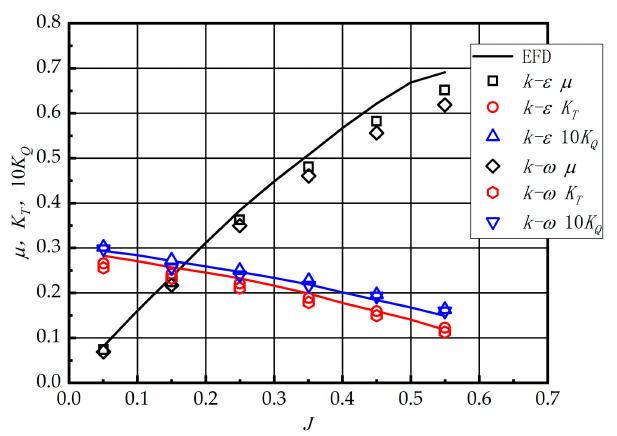
Figure 6. Validation of KP458 propeller open water